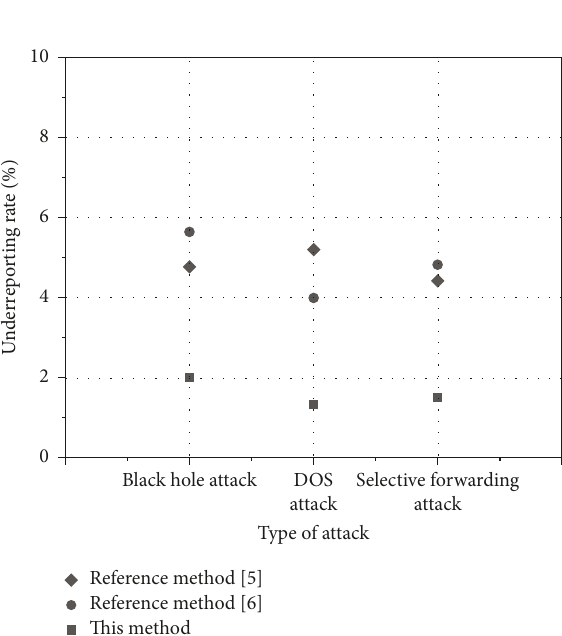
Figure 5: Discrimination results of the false alarm